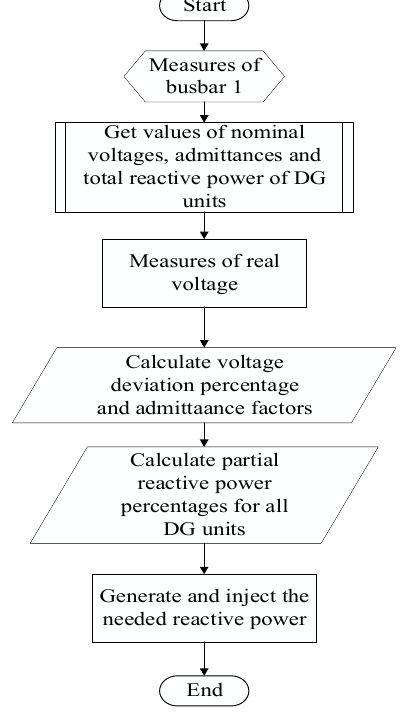
Figure 3. Proposed control algorithm of busbar No. 1.